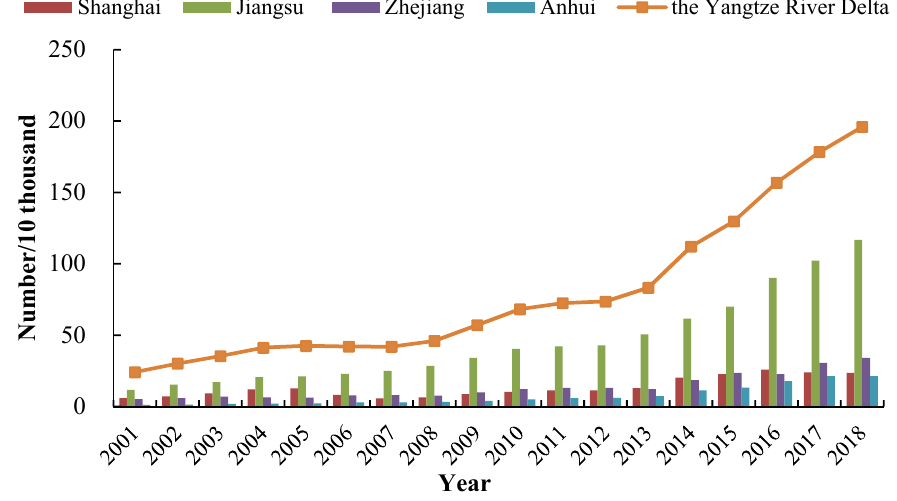
Figure 3. Changes in the number of startups in the Yangtze River Delta from 2001 to 2018.